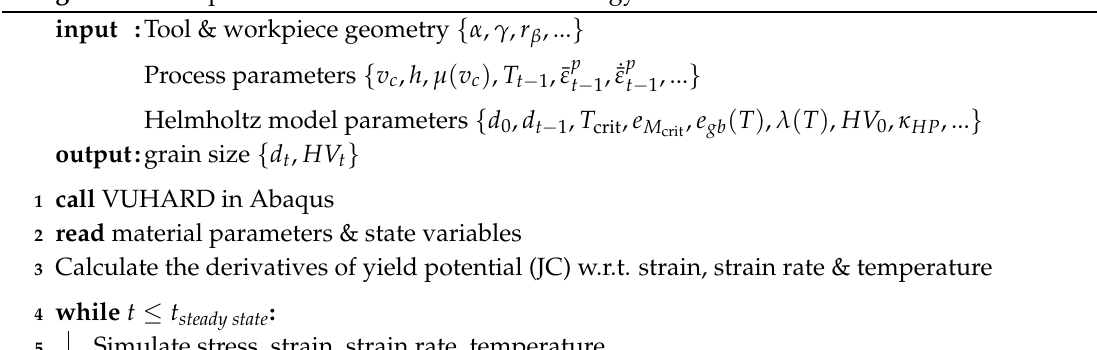
Algorithm 2: Implementation of Helmholtz free energy DRX